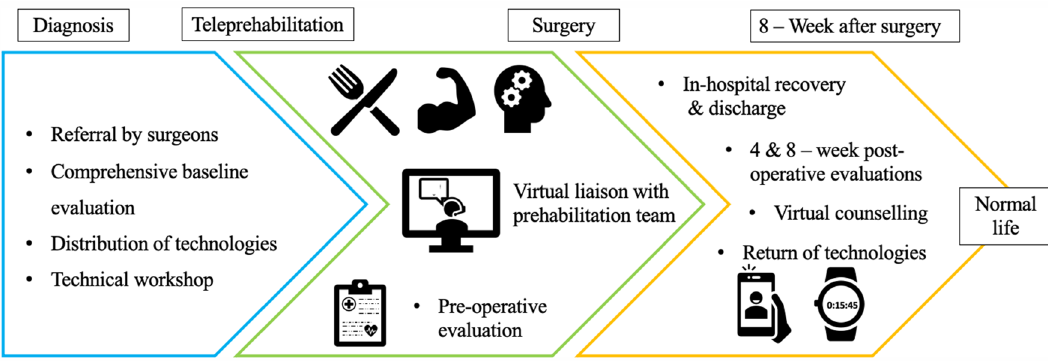
Figure 1. The Patient’s Trajectory through the teleprehabilitation